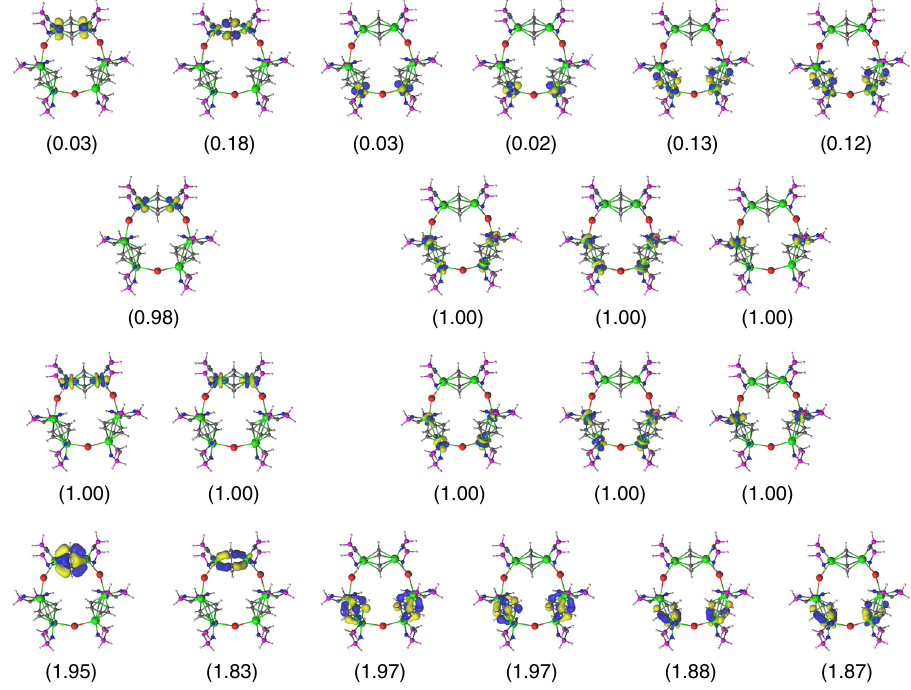
Fig. 7 Active natural orbitals from a RASSCF calculation on 4 ‴ . Electron occupation numbers are given in parentheses. Key: uranium, green; iodide, red; phosphorus, purple; nitrogen, dark blue; carbon, grey; hydrogen,